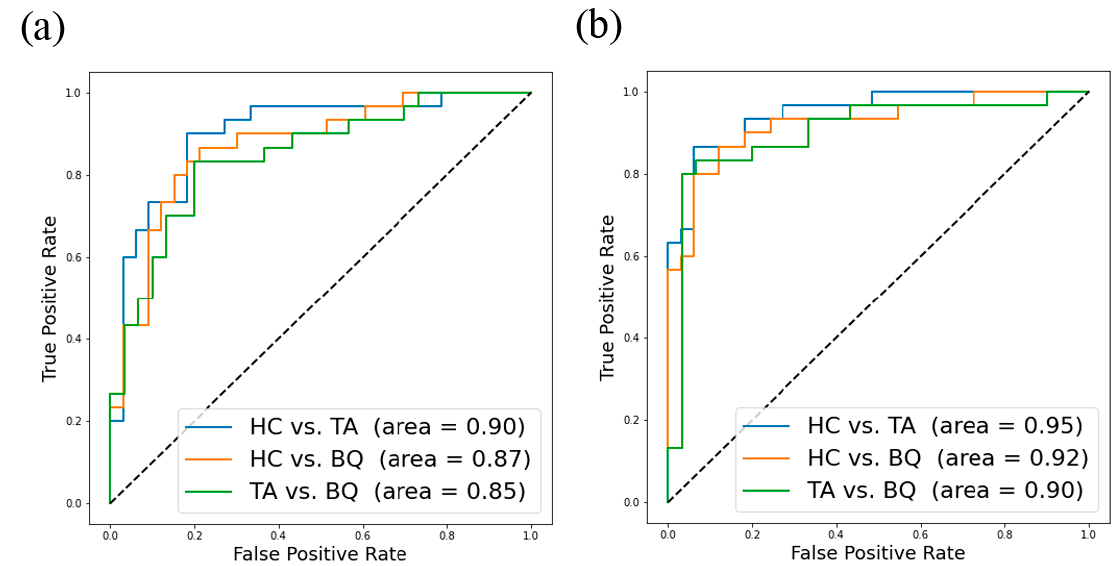
Figure 4. ROC curves and AUC of LR with ( a ) mfALFF (HC vs. TA, HC vs. BQ, and TA vs. BQ) and ( b ) mReHo (HC vs. TA, HC vs. BQ, and TA vs. BQ). Table 3. Classification results for different groups with each feature.